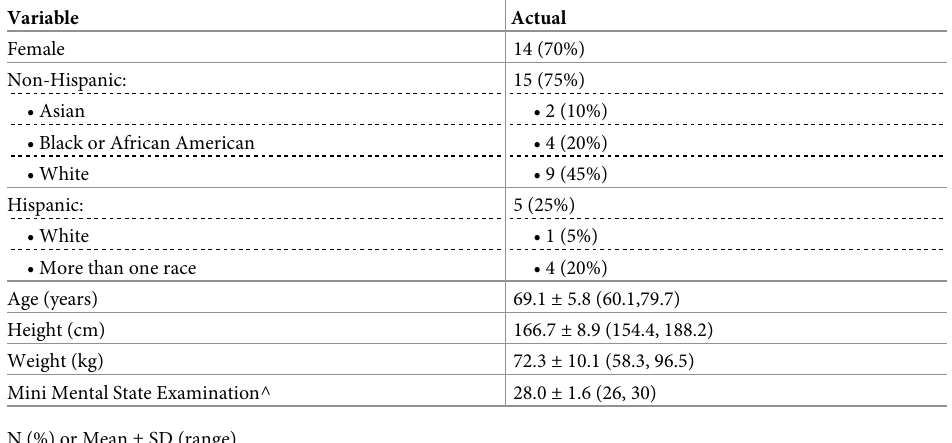
Table 1. Participant characteristics at baseline (N =